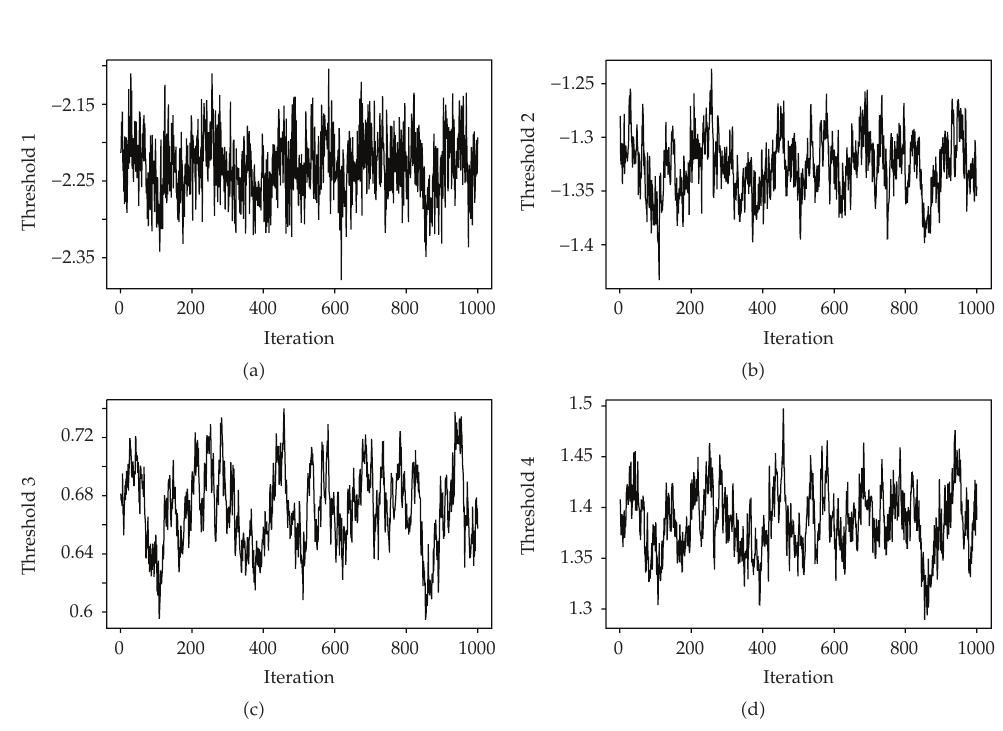
Figure 7: Sampling plots of threshold